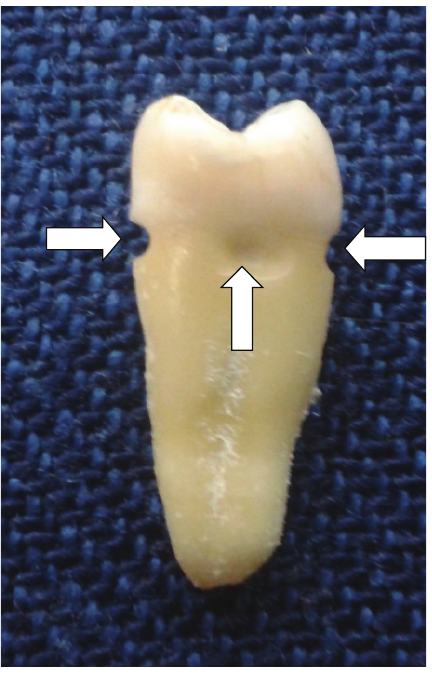
Figure 1: A photograph showing simulated defects below CEJ.